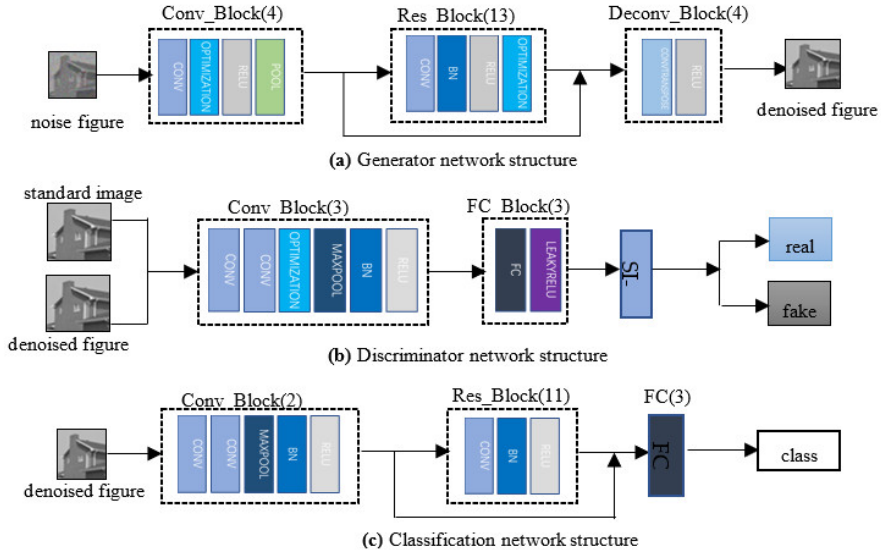
Figure 3. Sub-network